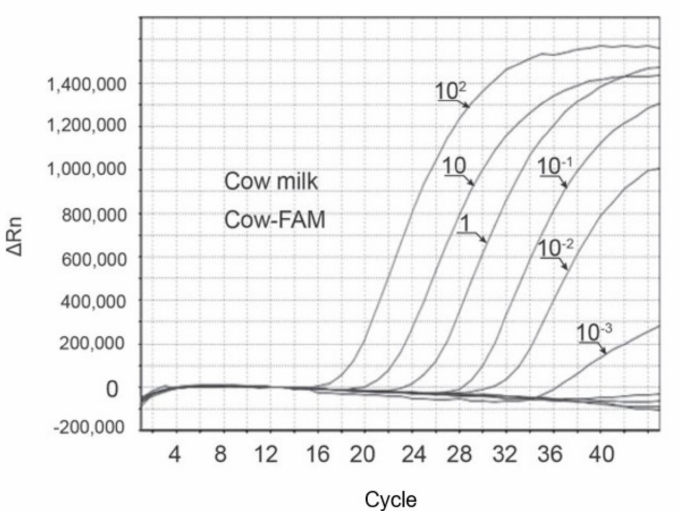
Figure 4. Real-time PCR amplification curves targeting the 12S rRNA gene of cow with a Taq- Man probe using serially diluted DNA (ng) extracted from cow’s milk. FAM, fluorescent reporter 6-carboxyfluorescein, ∆ Rn, change in normalized reported value. Reprinted from [132] with permis- sion from